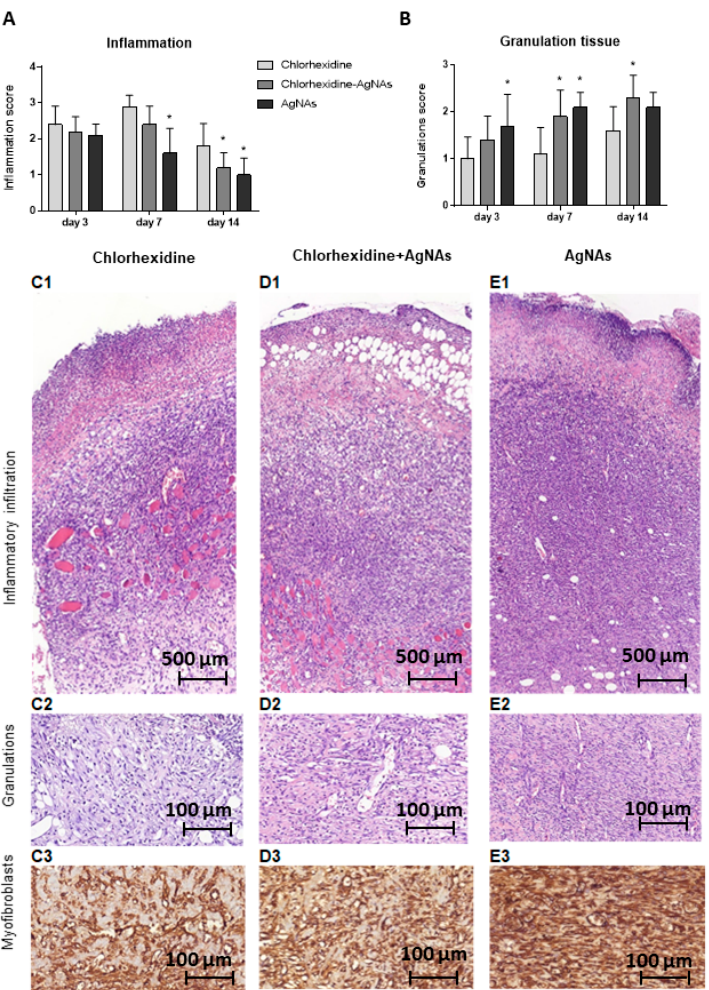
Figure 6. Inflammatory infiltration ( A ) and granulation ( B ) tissue formation in wounds treated with chlorhexidine ( C ), chlorhexidine–AgNAs ( D ) or AgNAs ( E ). The layer of granulation tissue was considerably thicker in rats treated with AgNAs ( E ) or chlorhexidine–AgNAs ( D ) compared with dressing with chlorhexidine. C1,2; D1,2; and E1,2 : Staining with hematoxylin and eosin. C3–E3 : Immunohistochemistry to alpha-smooth muscle actin (aSMA). *—significant difference from the control (chlorhexidine) groups ( p <